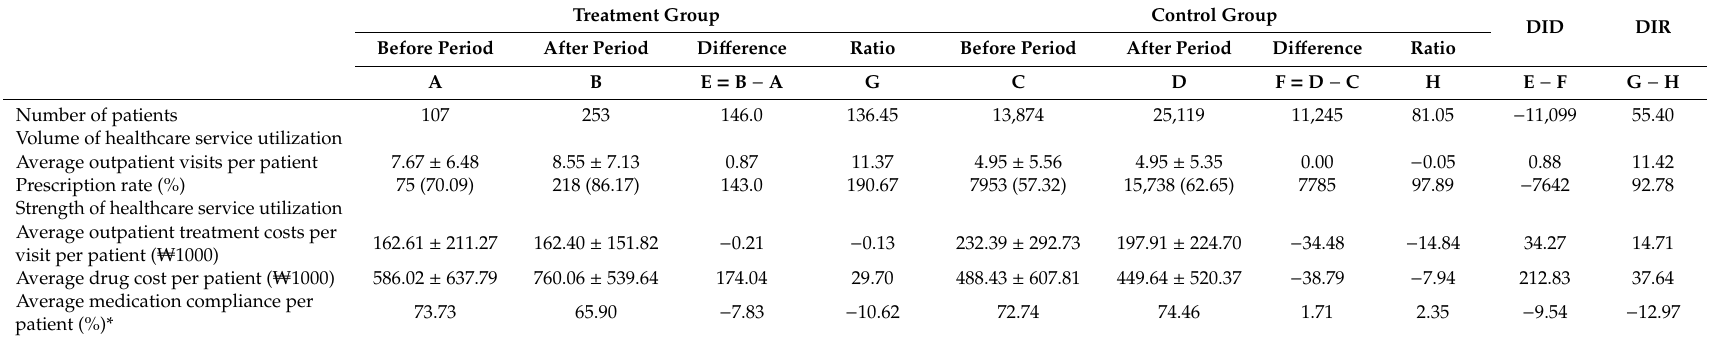
Table 2. Healthcare service utilization before and after the introduction of the dementia screening program (difference-in-difference analysis). Treatment Group Control Group